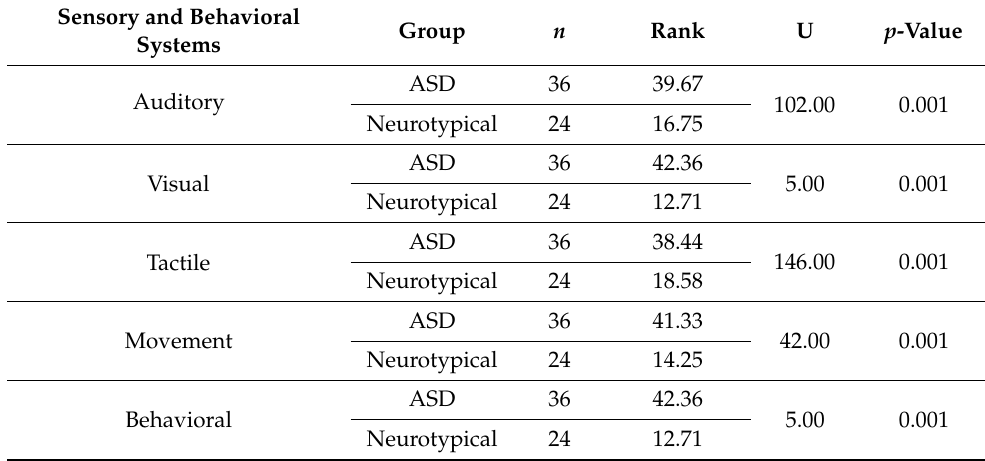
Table 2. Comparison of the scores obtained by children with ASD and neurotypical children in the category “sensory and behavioral